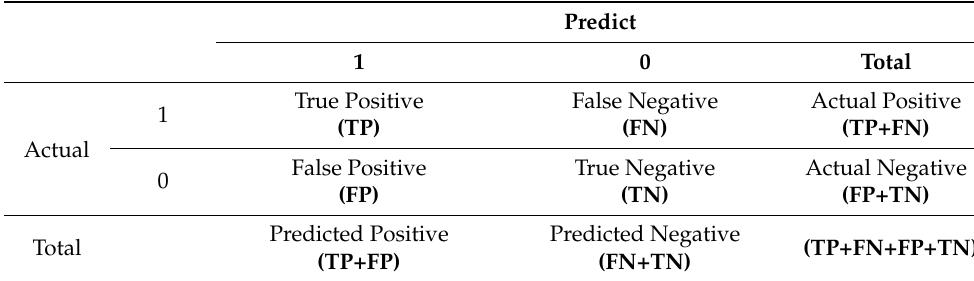
Table 4. Confusion